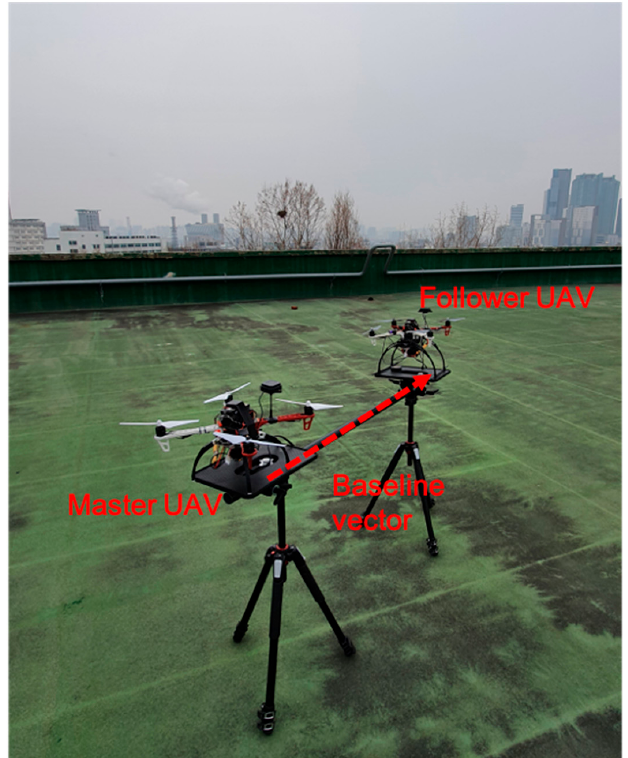
Figure 10. Proof-of-concept launchpad set-up for static tests at Hongik University, Seoul, Korea. Global Navigation Satellite System (GNSS) raw data were collected from two Ublox ZED-F9P re-